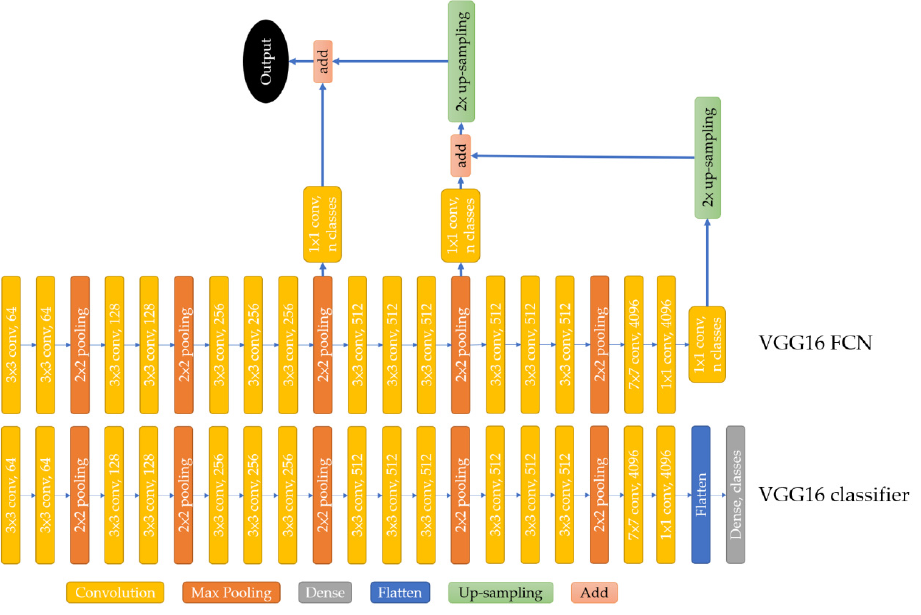
8 of 15 Figure 8. Operation of the convolutional neural network classifier. Figure 9. Mechanism of model selection.